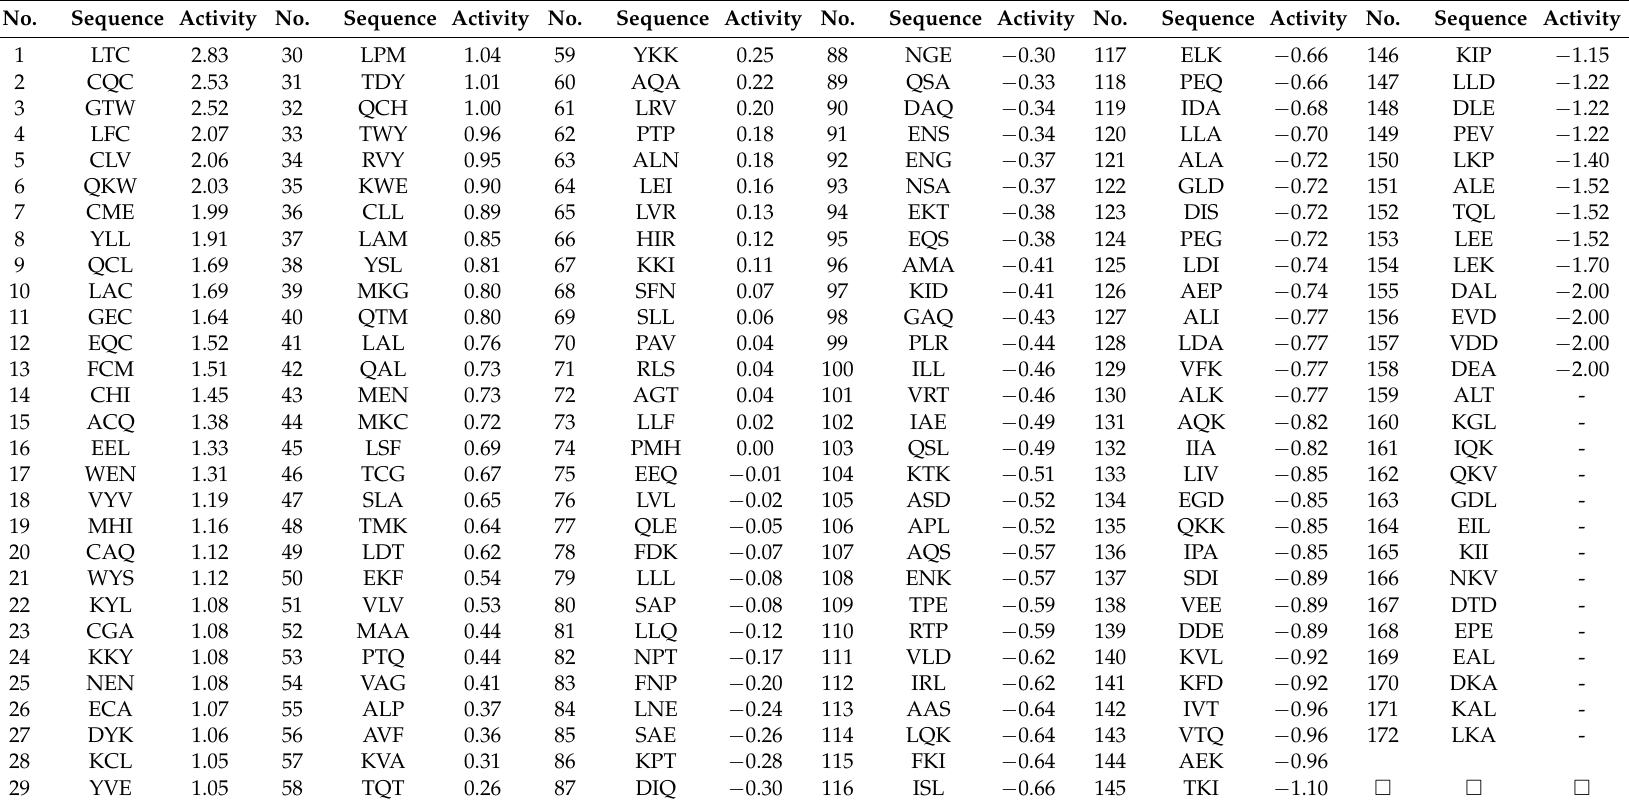
Table 4. Sequences and activities of tripeptides on ferric ion reducing antioxidant power (FRAP) dataset a